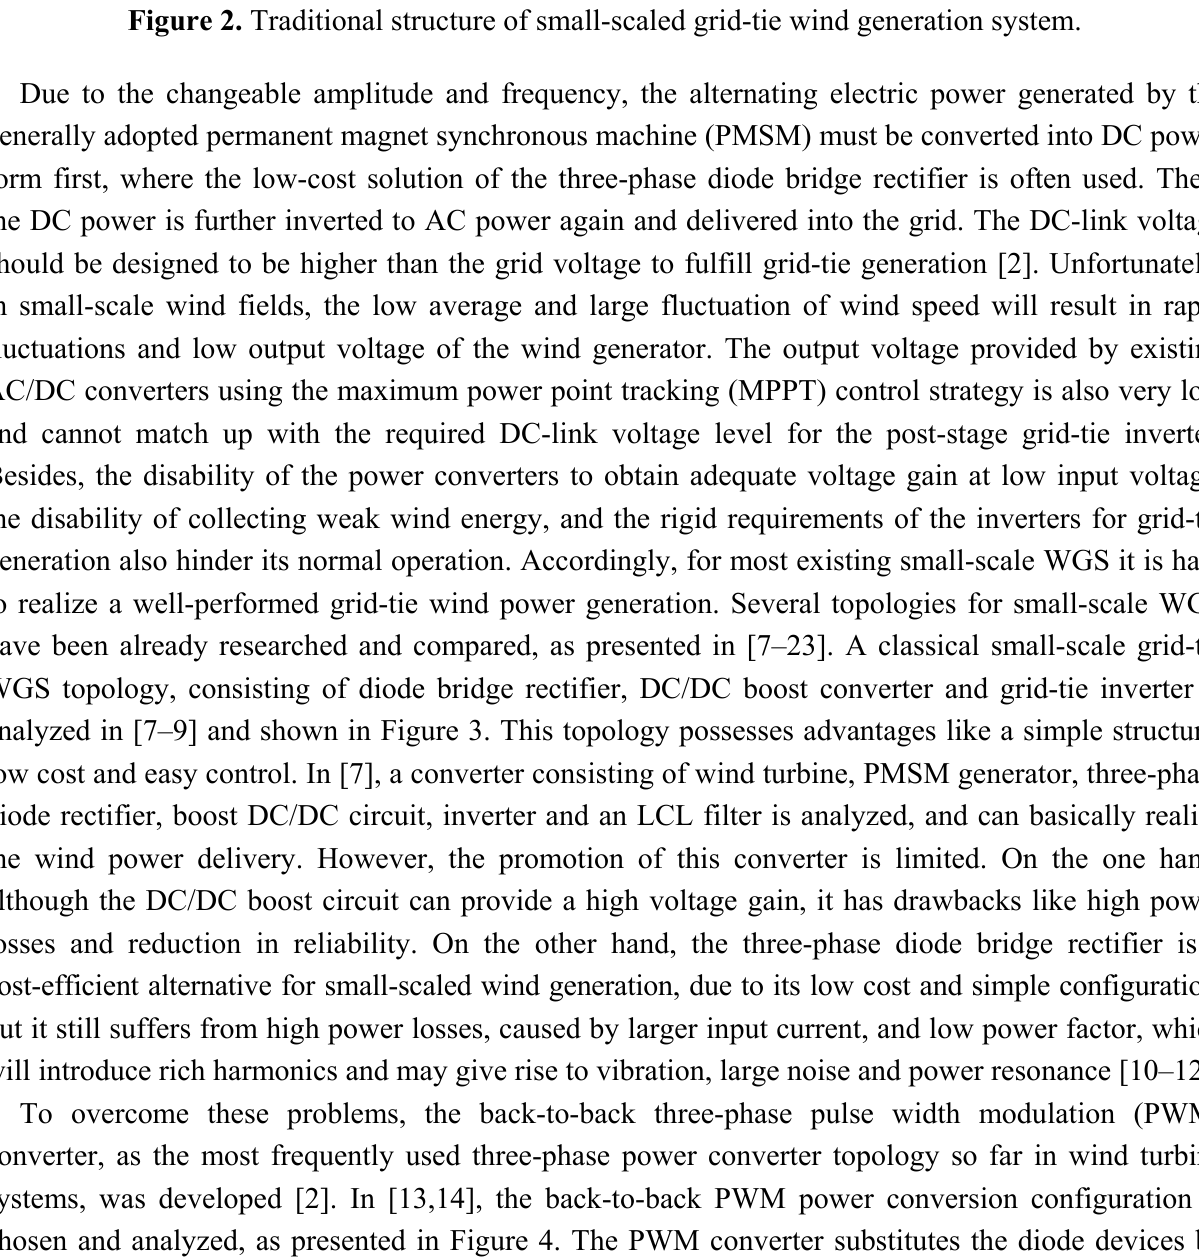
Figure 2. Traditional structure of small-scaled grid-tie wind generation